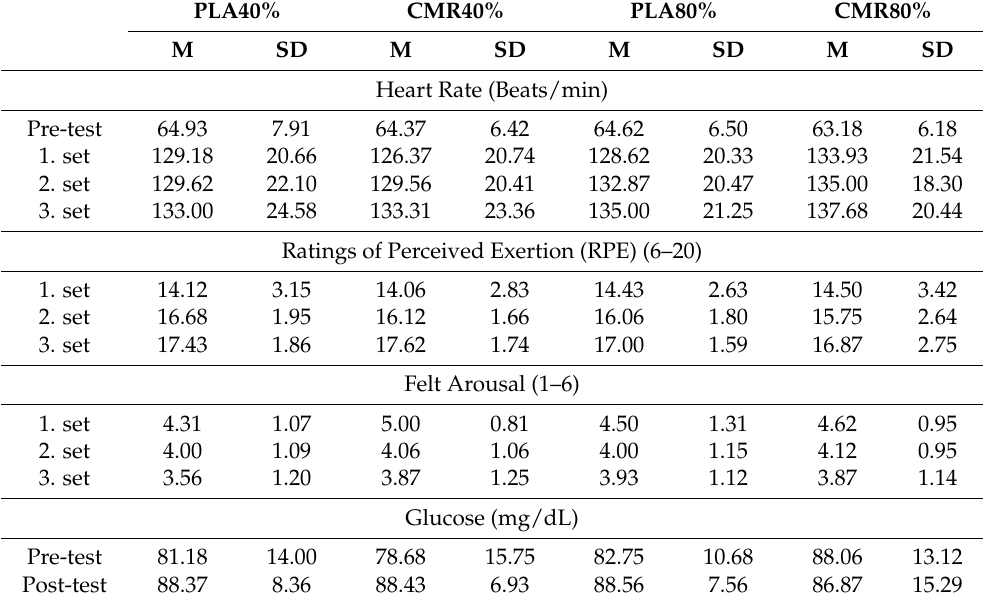
Table 1. Heart rate, RPE, felt arousal and glucose